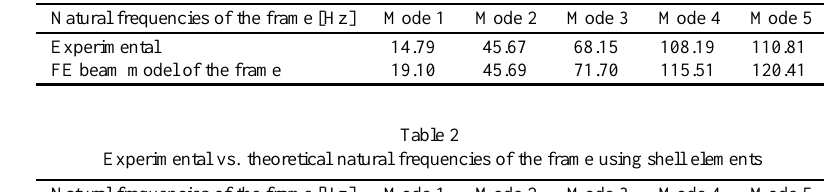
Table 1 Experimental vs. theoretical natural frequencies of the frame using beam elements